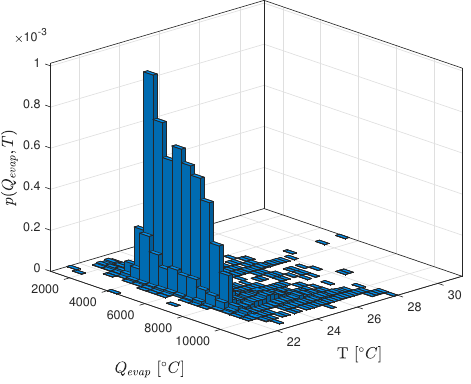
Figure 7. 3-D histogram of the pairs ( Q load , T ) recorded from February 2017 to January